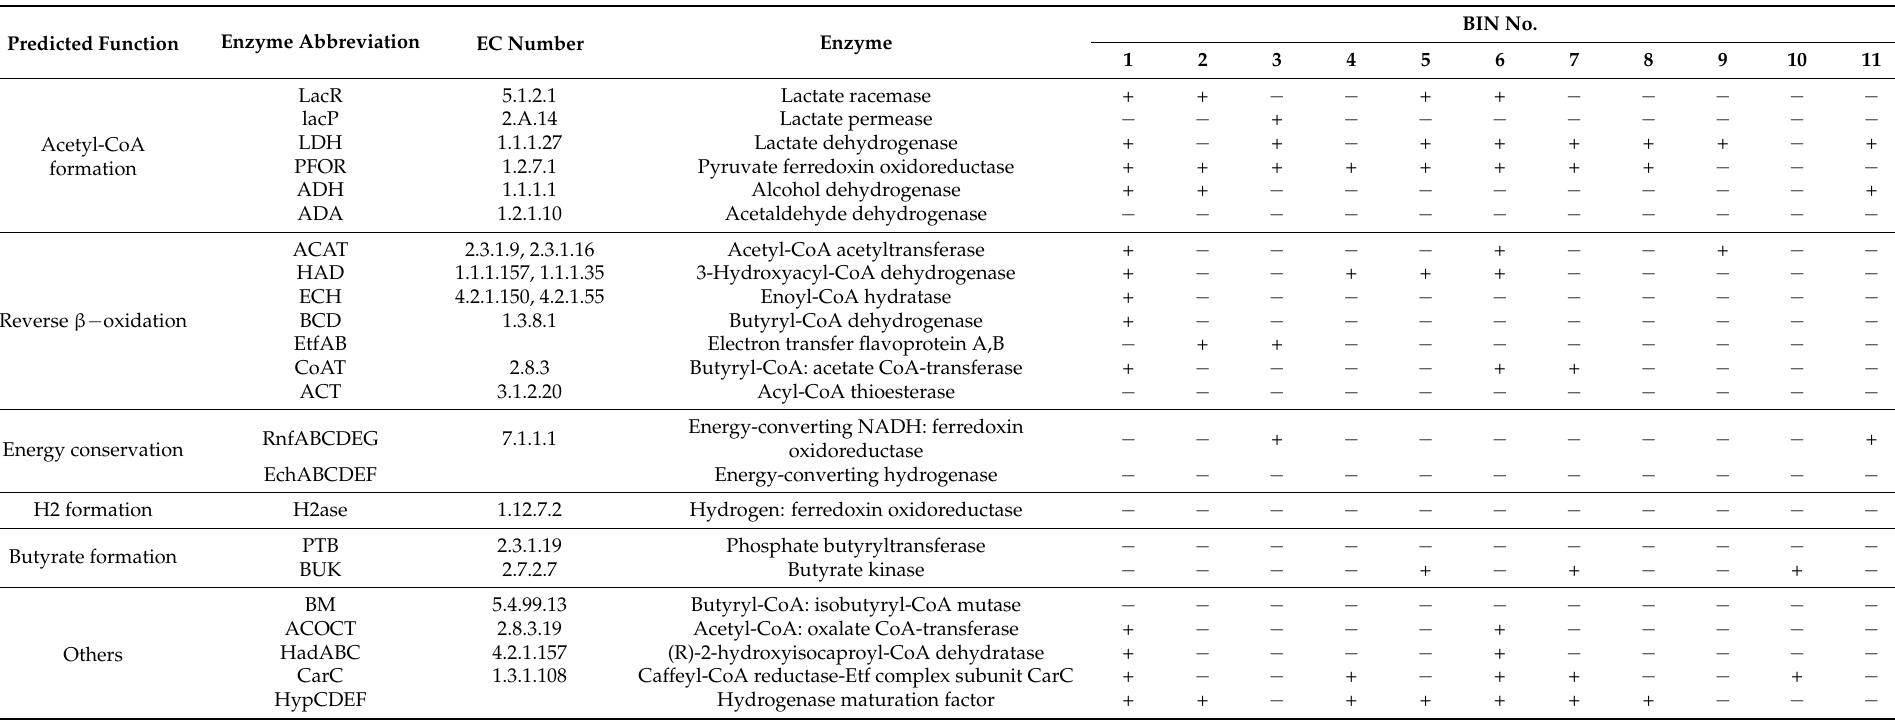
Table 4. Detailed information and presence of functional enzymes involved in acetyl-CoA formation, reverse β -oxidation, energy conservation, hydrogen formation, and butyrate formation in each bin according to Liu et al. [27]. +, present; − ,